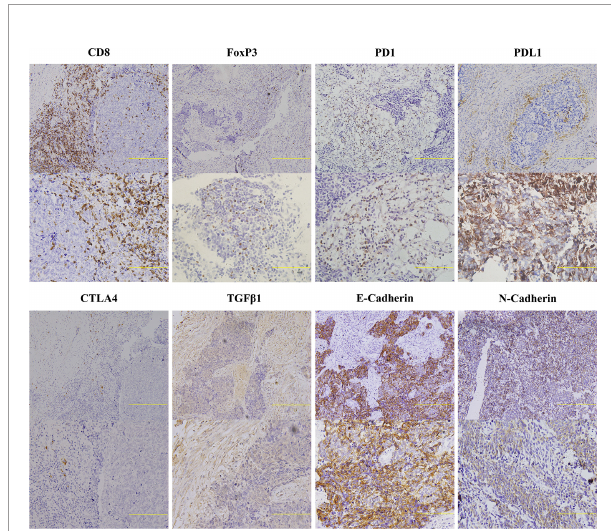
FIGURE 6 | Representative Images of Immunohistochemical Staining for Indicators Related to Cancer Immunity of Primary Small Cell Lung Cancer Tumors. Two immunohistochemical staining images with different scanning resolutions were selected for each immune-related marker (upper image: 20×, lower image: 40×). Scale bar: 100 m M. Only the lymphocytes with appreciable membrane staining were considered positive for CD8, PD1, PDL1, and CTLA4, and samples positive for FoxP3 were de fi ned as appreciable nuclear staining observed in lymphocytes. Tumors with membrane staining were considered positive for E-Cadherin, N-Cadherin, and TGF b 1. Extracellular staining for TGF b 1 was also considered to be positive. FoxP3, forkhead box P3; CTLA4, cytotoxic T lymphocyte antigen 4; PD1, programmed cell death 1; PDL1, programmed cell death ligand 1; TGF b 1, transforming growth factor beta